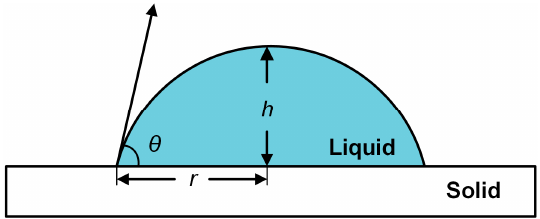
Figure 3. Static contact angle measurement using the θ /2 method.